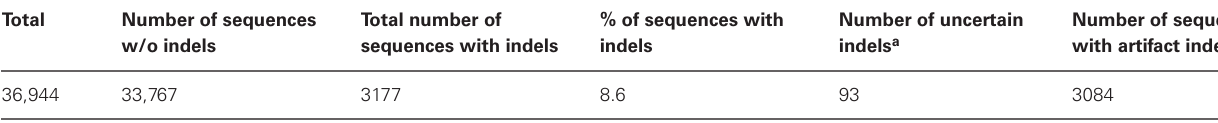
Table 4 | Numbers of sequences after Ig-Indel-Identifier cleaning. Total